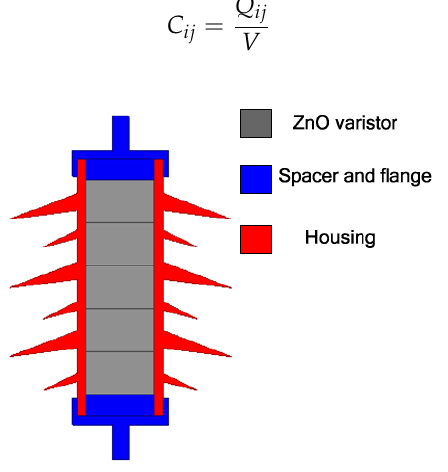
Figure 6. Finite element simulation model of MOA.